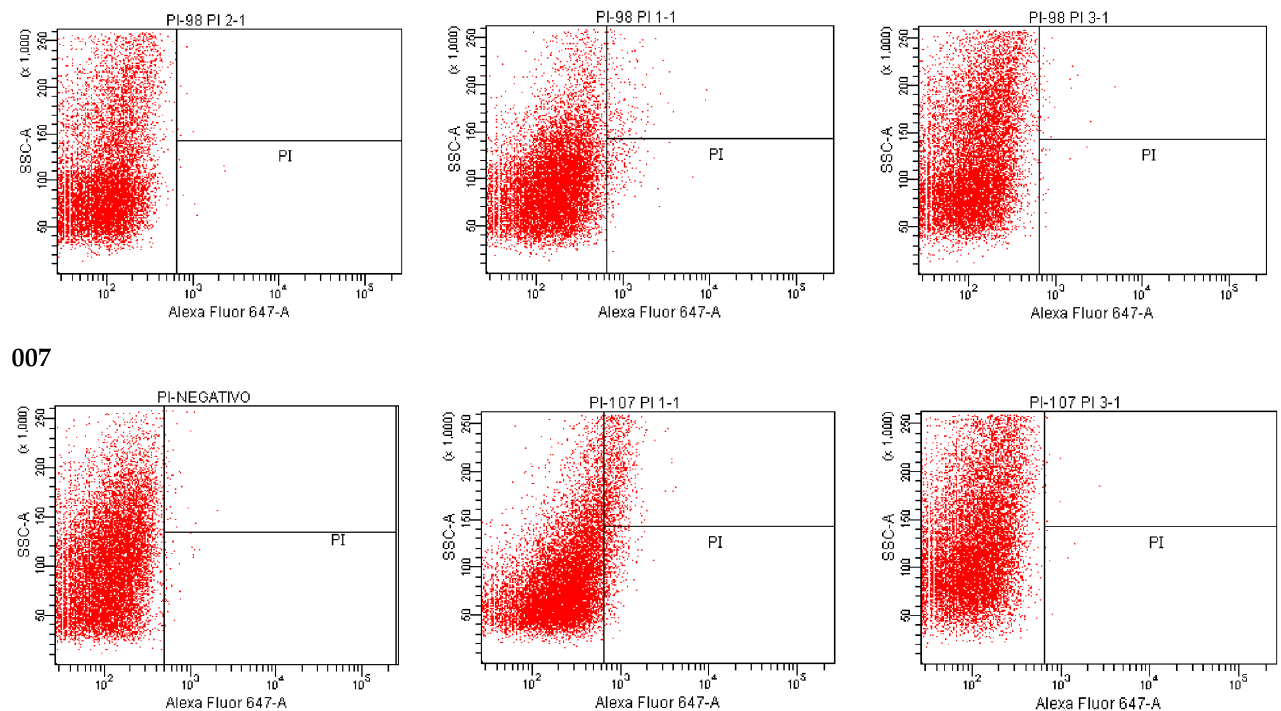
Figure 7. Changes in membrane permeability of clinical isolates of C. tropicalis treated with ISO: PI staining for detection of membrane permeability disruption in C. tropicalis . ( a ) untreated cells, ( b ) cells treated with ISO, and ( c ) cells treated with FLZ (MIC µg/mL).